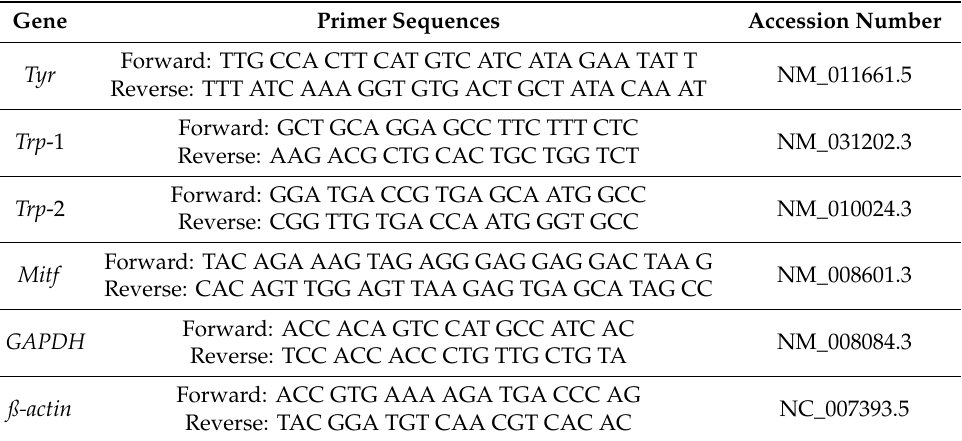
Table 1. Sequences of Tyr , Trp -1, Trp -2 and Mitf used in